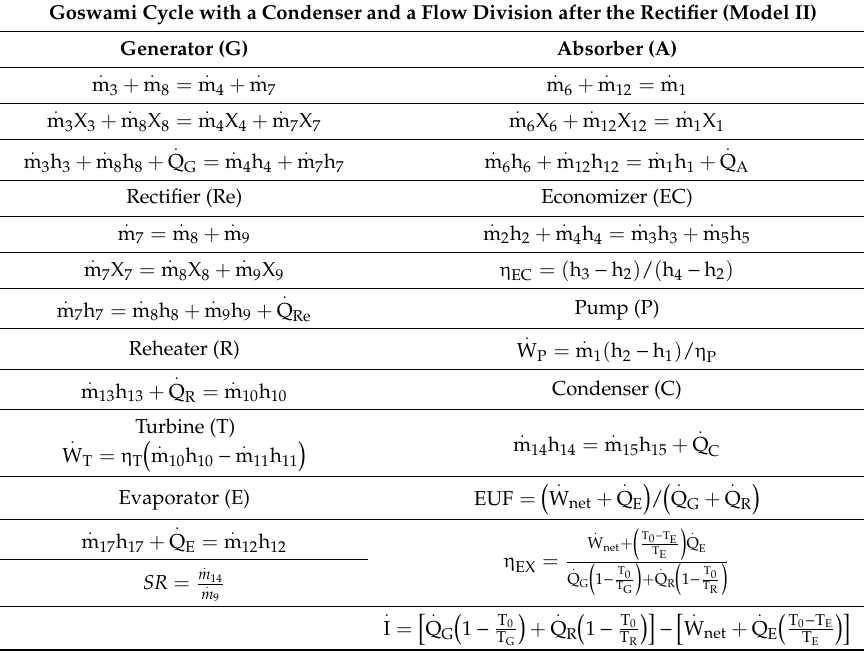
Table 2. Main equations for the Goswami cycle with flow division.